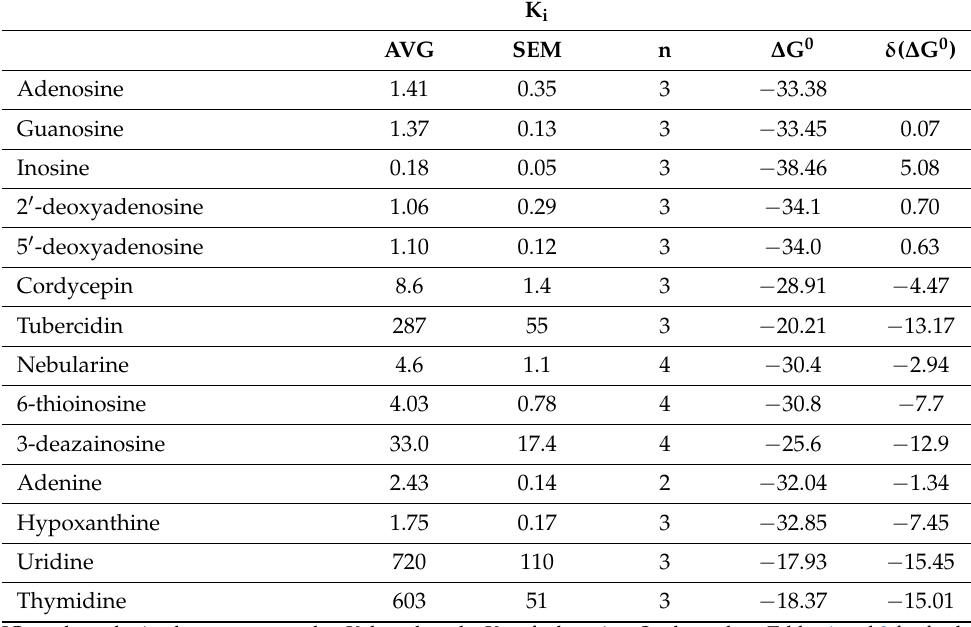
Table 4. K i for purines on the transport of [ 3 H]-adenosine by